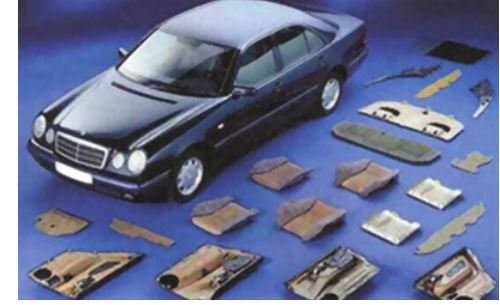
Figure 2: The function of the compatibilizing agent in the lignocel- lulosic filler-polyolefin composite system [11].